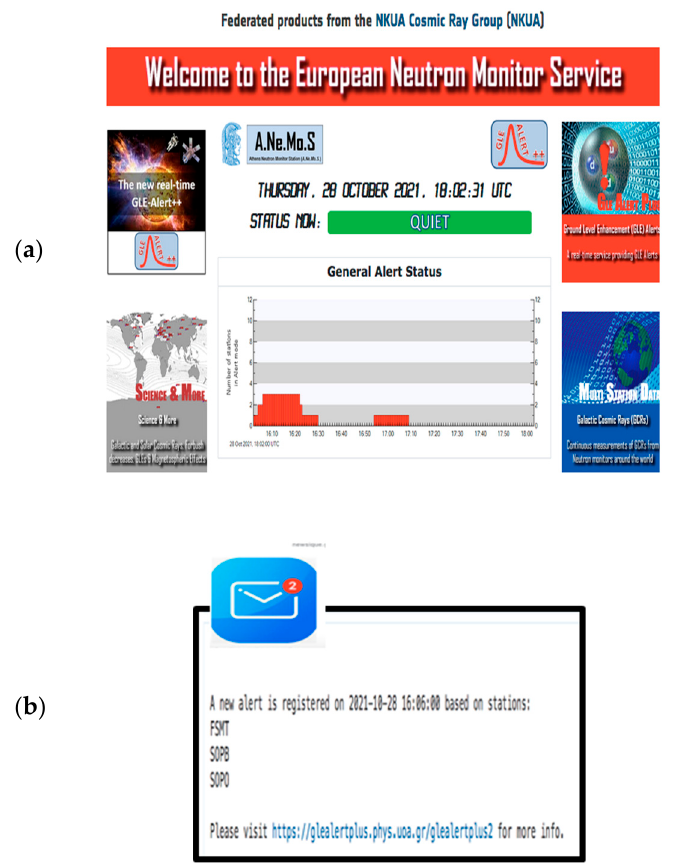
Figure 7. ( a ) The GLE Alert Plus application on the ESA SWE portal and ( b ) the notification via e- mail.